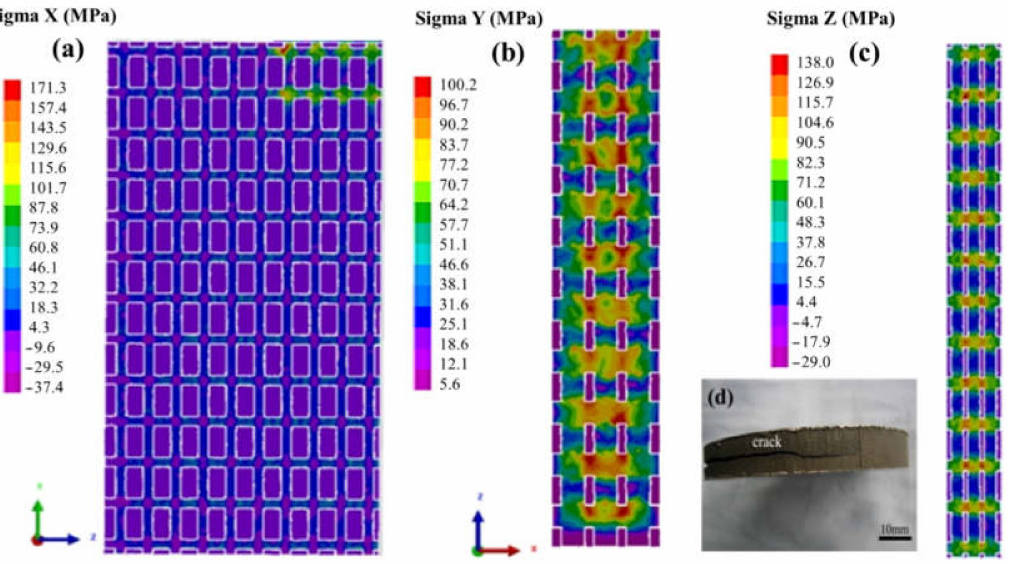
Figure 4. The distribution of normal stress: ( a ) σ x in the y–z section; ( b ) σ y in the x–z section; ( c ) σ z in the x–y section. ( d ) The crack of the SiC/Al